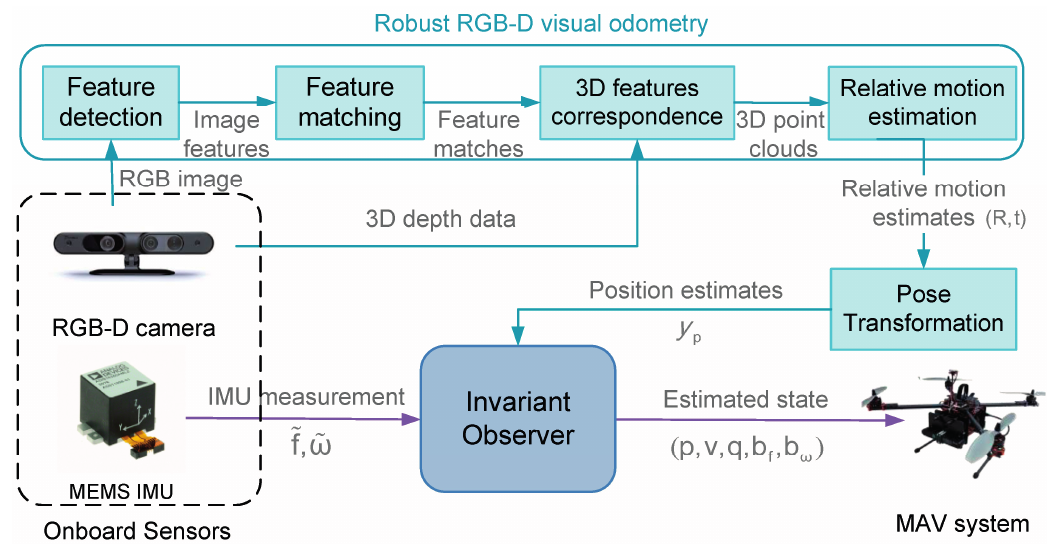
Figure 1. Block diagram of the RGB-D visual/inertial navigation scheme. MEMS, micro-electro-mechanical system; IMU, inertial measurement unit; MAV, micro-aerial